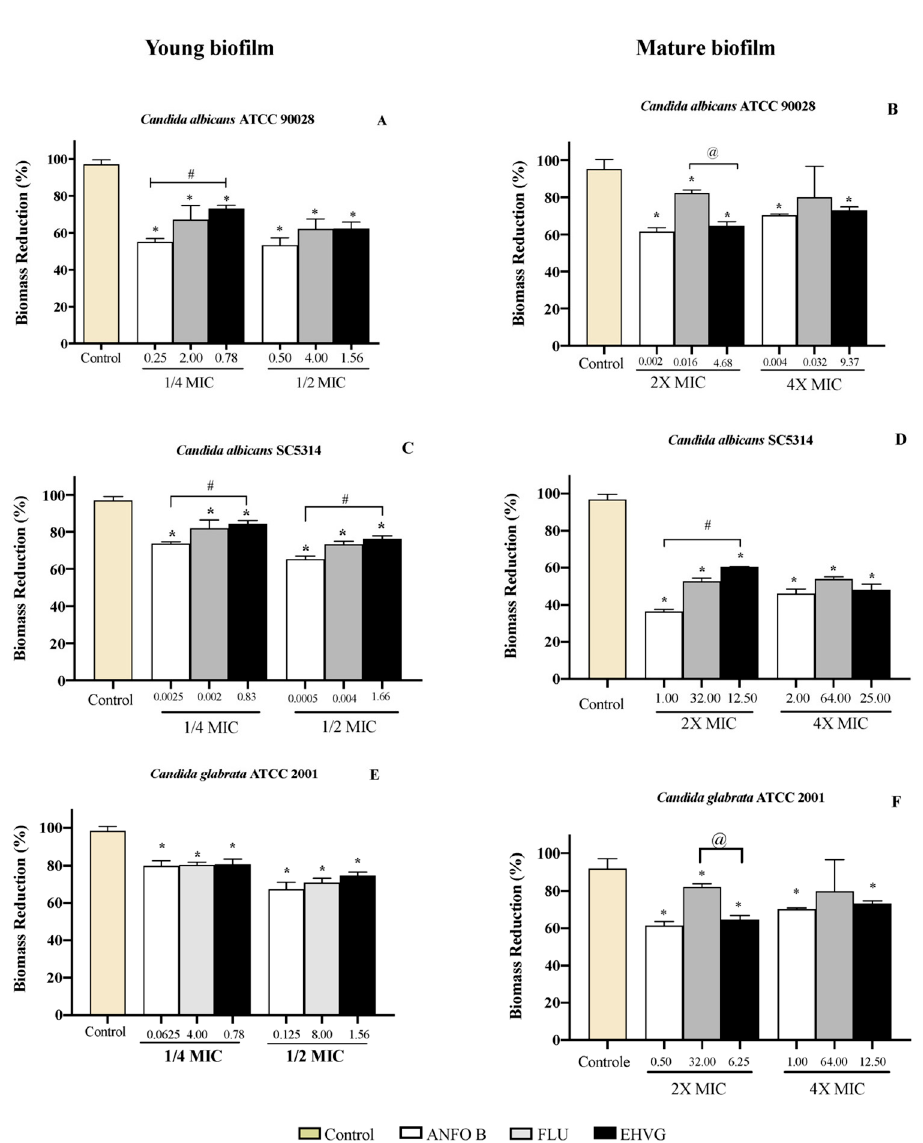
Figure 10. Reductions in biofilm biomass stained with crystal violet (CV) of Candida spp. (ATCC 90028, A , B ), (ATCC 2001, C , D ) and (SC5314, E , F ) after 48 and 72 h. The samples were treated with EHVG and compared to untreated controls or to the reference drugs Amphotericin B (AMHO B) and Fluconazole (FLU). (*) p < 0.05 differs from control; (#) p < 0.05 differs from Amphotericin B and (@) p <0.05 compared to